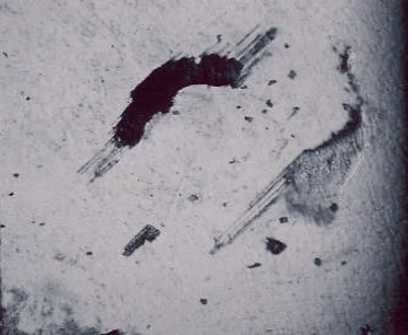
Figure 18. Microelectrode positioned on the link, longitudinal surface. Optical examination, magni- fication 20×, Sample #6.